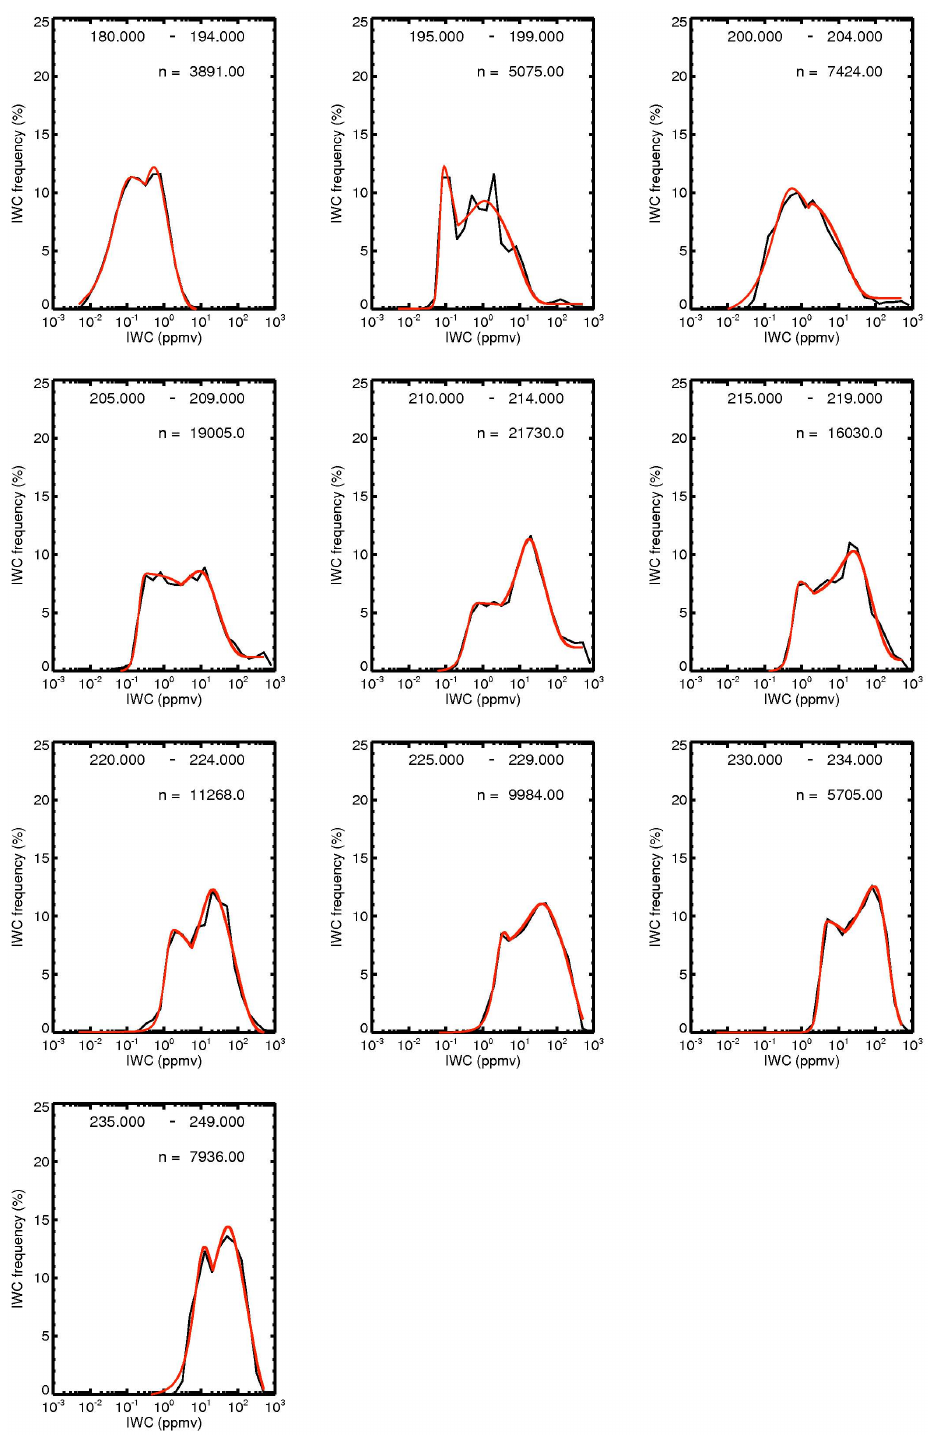
Fig. 7. PDFs of IWC in various temperature ranges. The black lines are the PDF, the red lines are the curve fits.